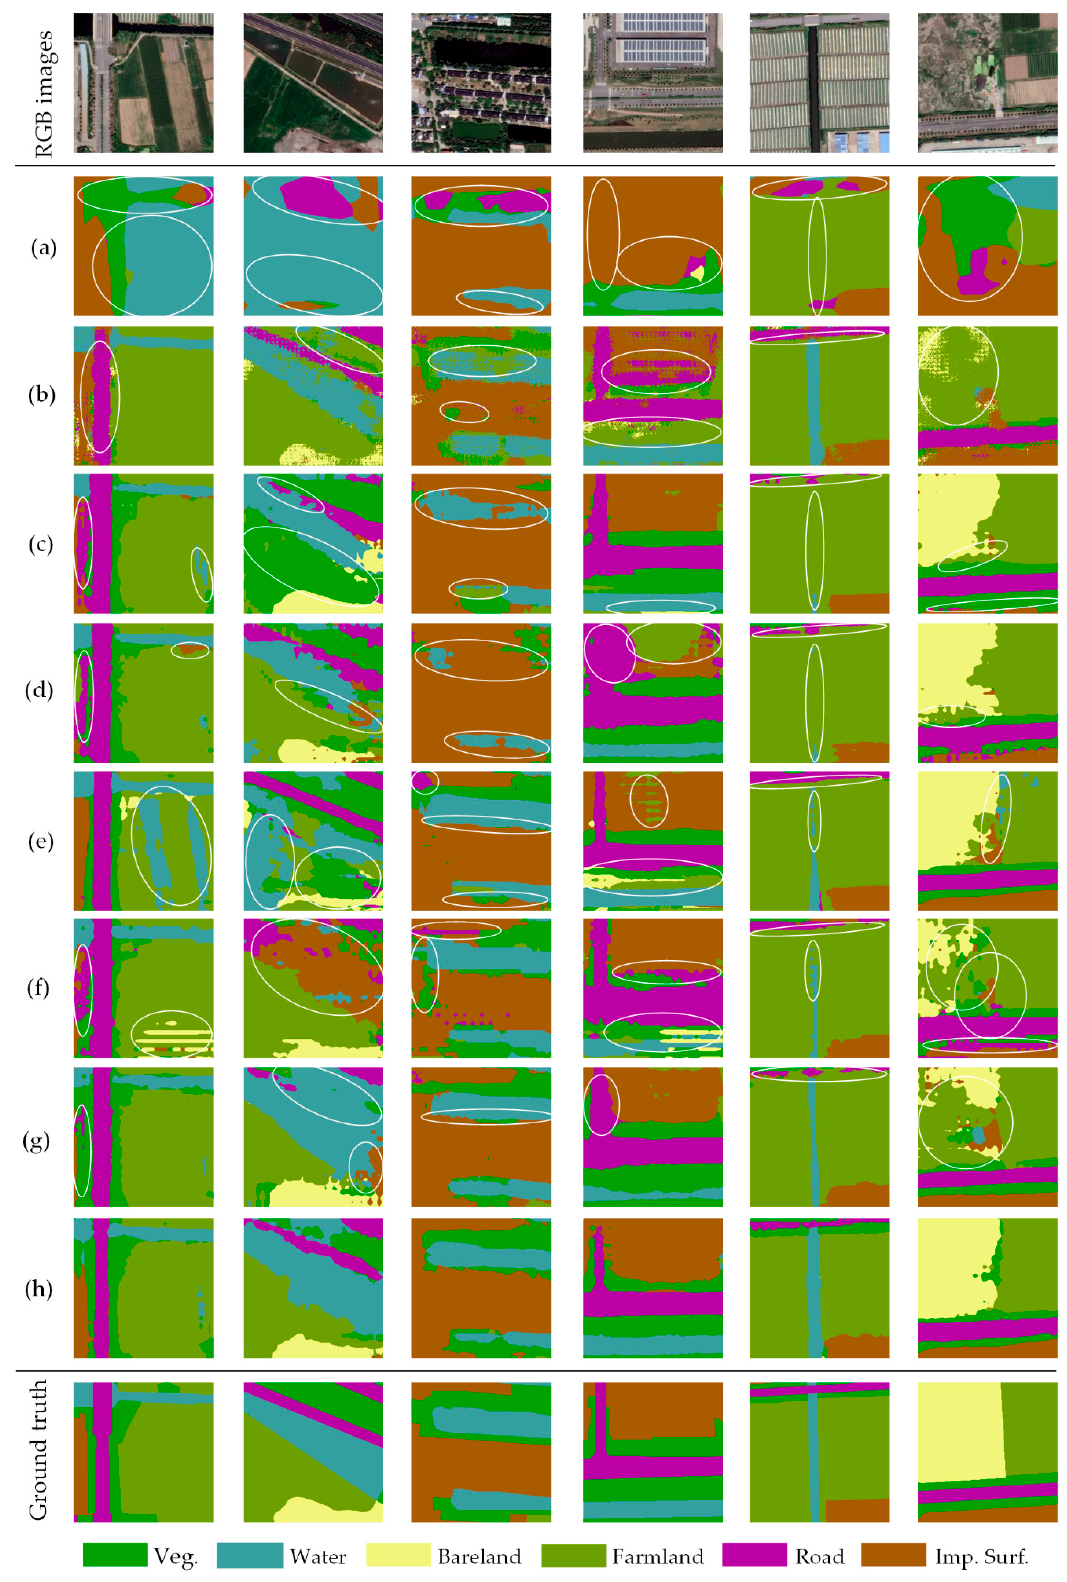
Figure 7. Representative examples of land cover mapping on the task Zhejiang → Shanghai: ( a ) FCNs ITW, ( b ) CyCADA, ( c ) AdaptSegNet, ( d ) CLAN, ( e ) ADVENT, ( f ) BDL, ( g ) FADA, ( h ) our CsCANet. RGB images and the corresponding ground truth are presented in unison. We circle the negative results in white ellipses.